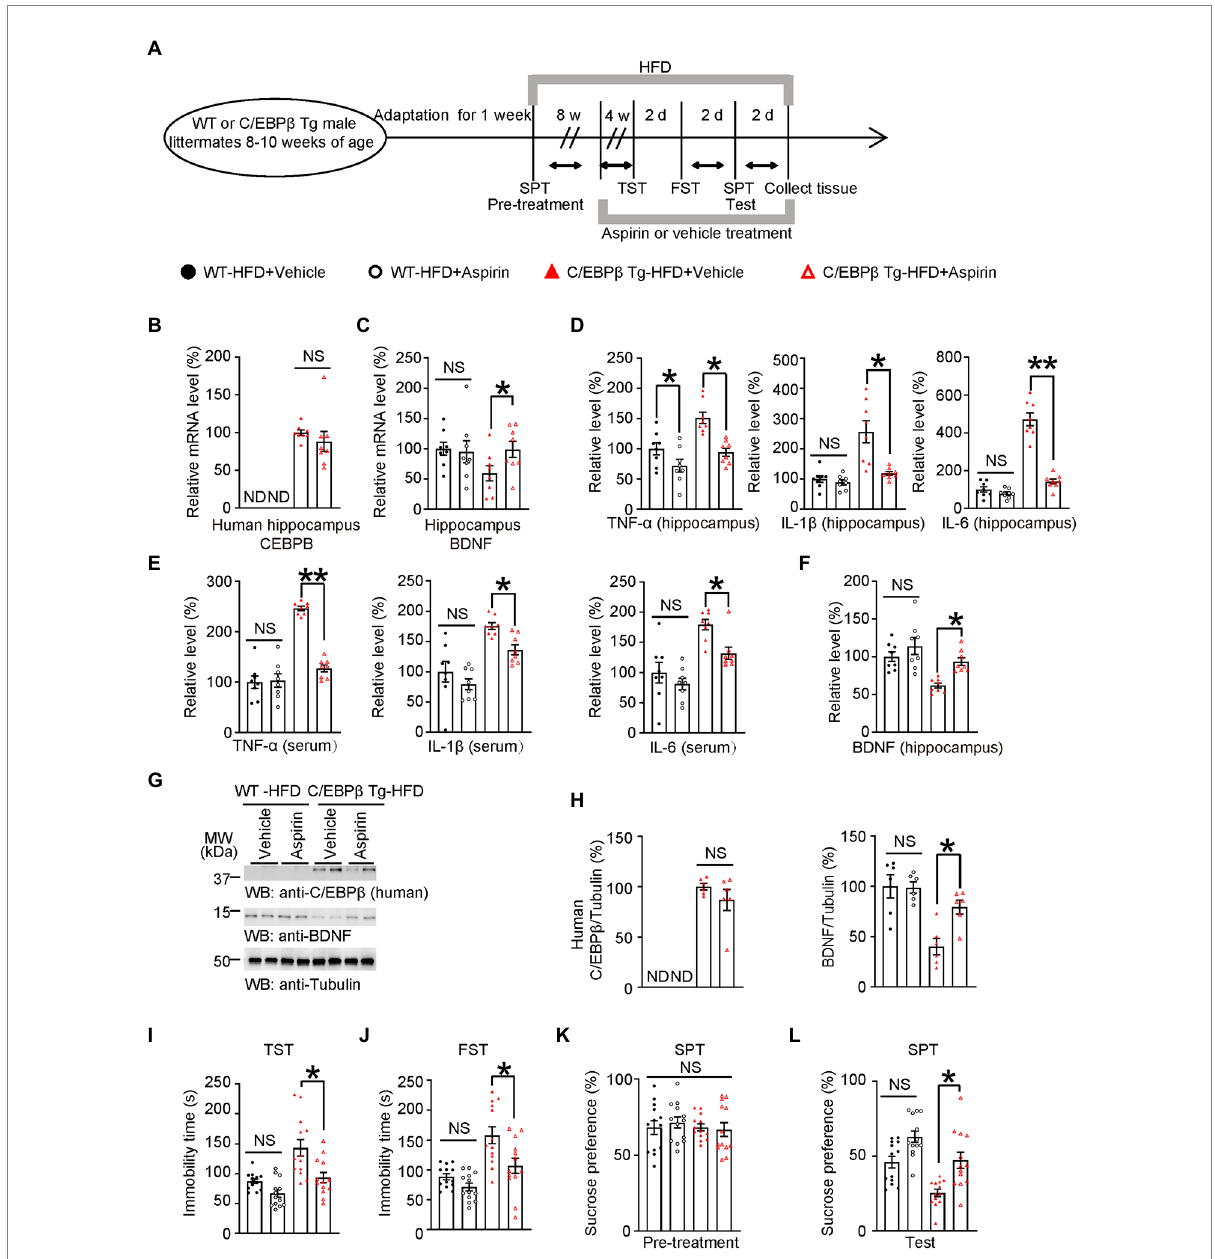
FIGURE 6 Aspirin alleviates HFD-induced depression-like behaviors in Thy1-C/EBP β Tg mice. (A) Schematic of the HFD or chow diet course, aspirin or vehicle treatment course, and behavioral testing process in wild-type and Thy1-C/EBP β Tg male mice. HFD, high-fat diet; TST, tail suspension test; FST, forced swim test; SPT, sucrose preference test; d, day. (B,C) Hippocampal (B) human CEBPB and (C) BDNF mRNA levels in the above mice. Data in (B) represent the mean ± SEM ( n = 8 for each group; ND, not detected; NS, not significant; unpaired t -test with Welch’s correction). Data in (C) represent the mean ± SEM ( n = 8 for each group; * p < 0.05; NS, not significant; one-way ANOVA and Bonferroni’s multiple comparison test). (D,E) ELISA quantification of TNF α , IL-1 β , and IL-6 in hippocampus lysates (D) and serum (E) from the above mice. Data represent mean ± SEM of eight samples per group (* p < 0.05, ** p < 0.01; NS, not significant; one-way ANOVA and Bonferroni’s multiple comparison test). (F) ELISA quantification of BDNF in hippocampus lysates from the above mice. Data represent the mean ± SEM of eight samples per group (** p < 0.01; NS, not significant; one- way ANOVA and Bonferroni’s multiple comparison test). (G) Representative immunoblots and (H) quantification of human C/EBP β and BDNF protein expression in the hippocampus after aspirin or vehicle treatment. Data are representative of three independent experiments. Data in (H) represent the mean ± SEM [ n = 6 for each group; * p < 0.05; ND, not detected; NS, not significant; unpaired t -test with Welch’s correction (left); one-way ANOVA and Bonferroni’s multiple comparison test (right)]. (I) Tail suspension test, (J) forced swim test and (K,L) sucrose preference test results for the above mice. Data represent the mean ± SEM ( n = 13 mice per group; * p < 0.05; NS, not significant; one-way ANOVA and Bonferroni’s multiple comparison